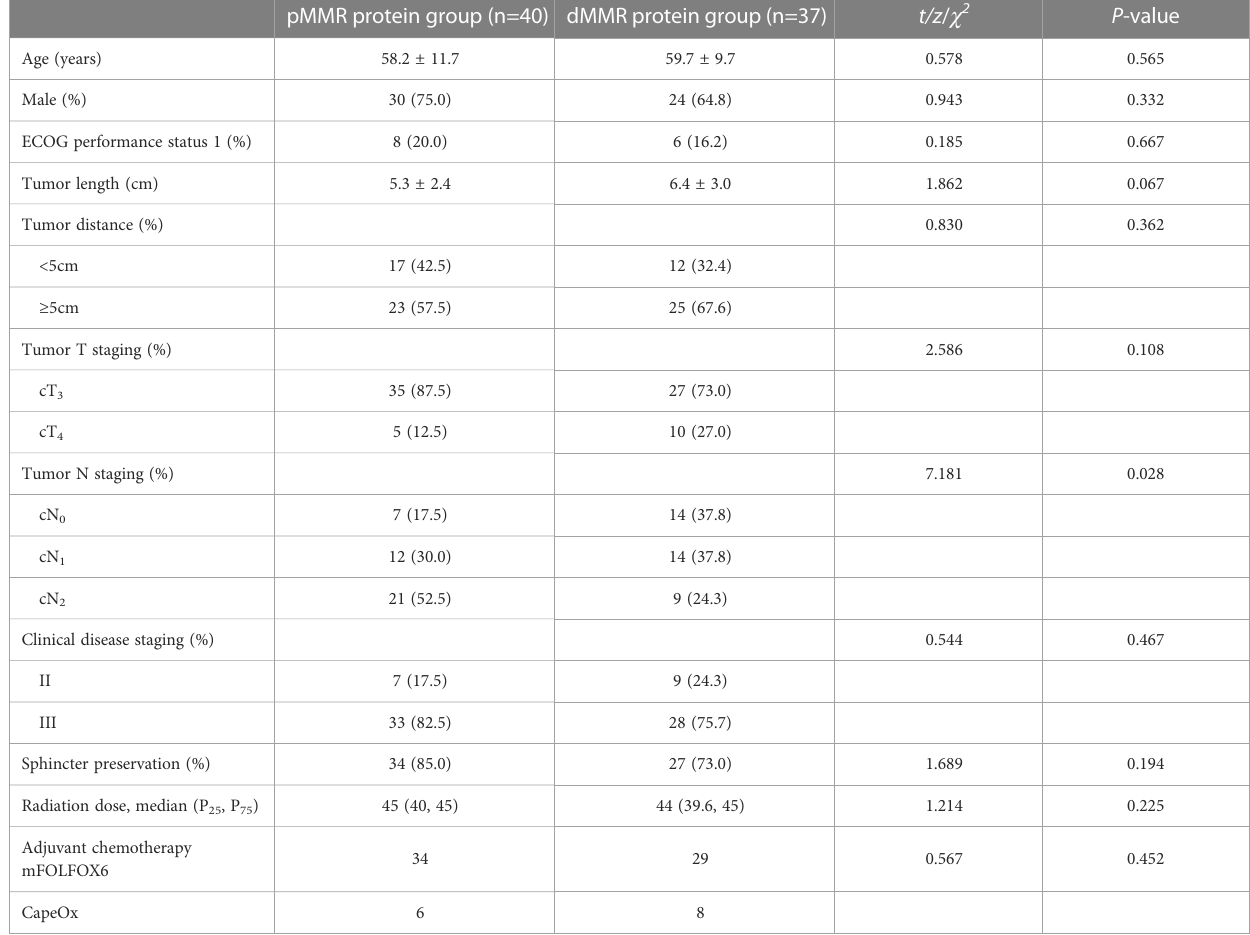
TABLE 1 Demographic characteristics of the